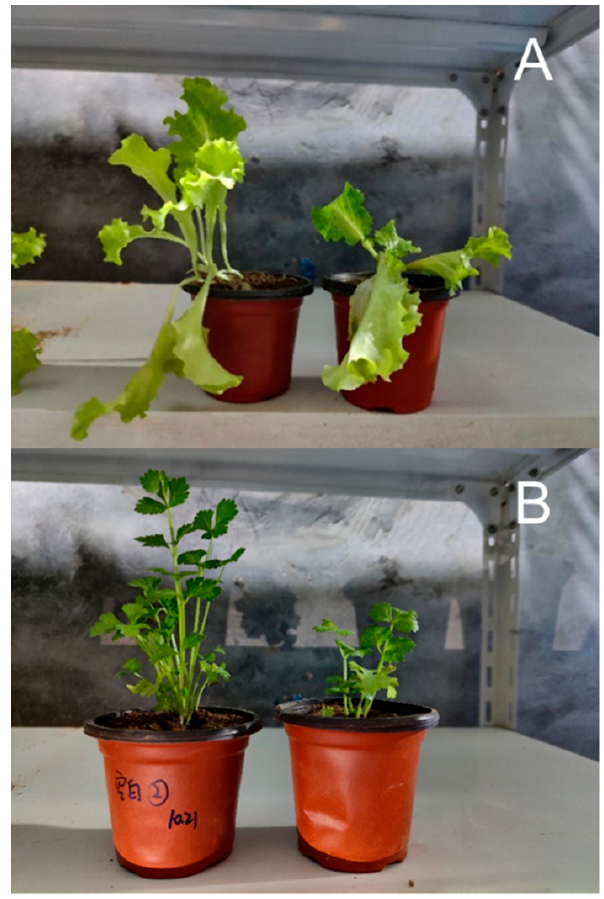
Figure 2. Comparison of the appearance of lettuce ( A ) and celery ( B ) (the left side is the blank plant, and the right side is the plant planted in AA-contaminated soil). The concentration of AAs in celery plants gradually increased with time over 21 days after their exposure to AAs (Figure 4). The concentrations of AA I and AA II in celery leaves on day 21 were 0.115 µ g/g and 0.077 µ g/g, respectively. Subsequently, a decreasing trend was observed. According to previous studies, the leaf clump growth period was approximately 30 to 40 days. In this experiment, the leaf clump had already begun to grow when transplanted. Therefore, the number of leaves was the highest at around 28 days, and the growth rate of the concentration slowed down with the increase in the number of leaves. After 28 days, the number and size of leaves were basically stable, and the concentration changes tended to be